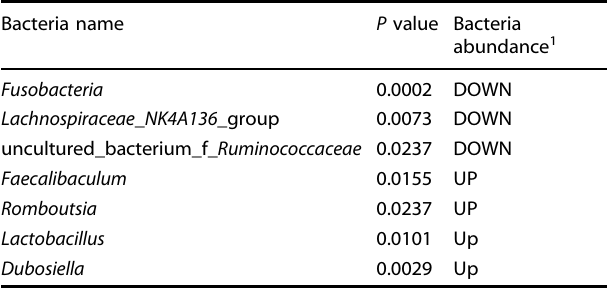
Table 1. The bacteria with a signi fi cant difference of relative abundance on the genus level between the Model group and the Lyc group ( p < 0.05).